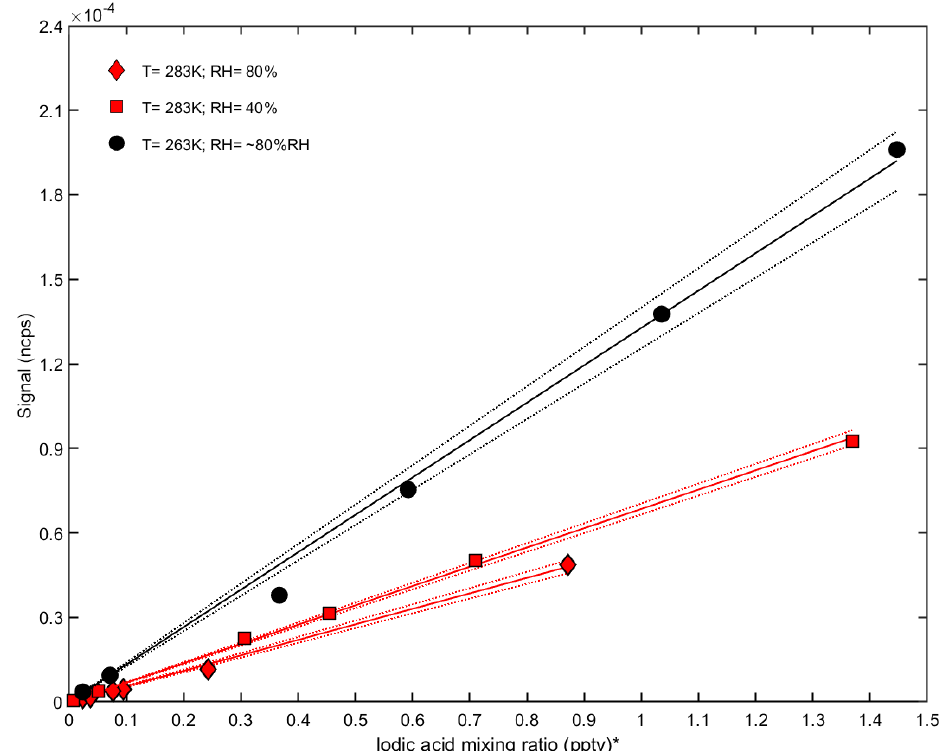
Figure 6. Calibration curves for iodic acid at different relative humidities and temperatures in the CLOUD chamber. The normalized counts per second ( y axis) are shown against the iodic acid mixing ratio measured with a nitrate CI-APi-TOF ( x axis). The sensitivity increases at lower temperatures (black line), while no strong dependency on relative humidity is found at 283K (red line). ∗ Note that the iodic acid mixing ratio is derived by applying a calibration factor for sulfuric acid to the nitrate CI-APi-TOF